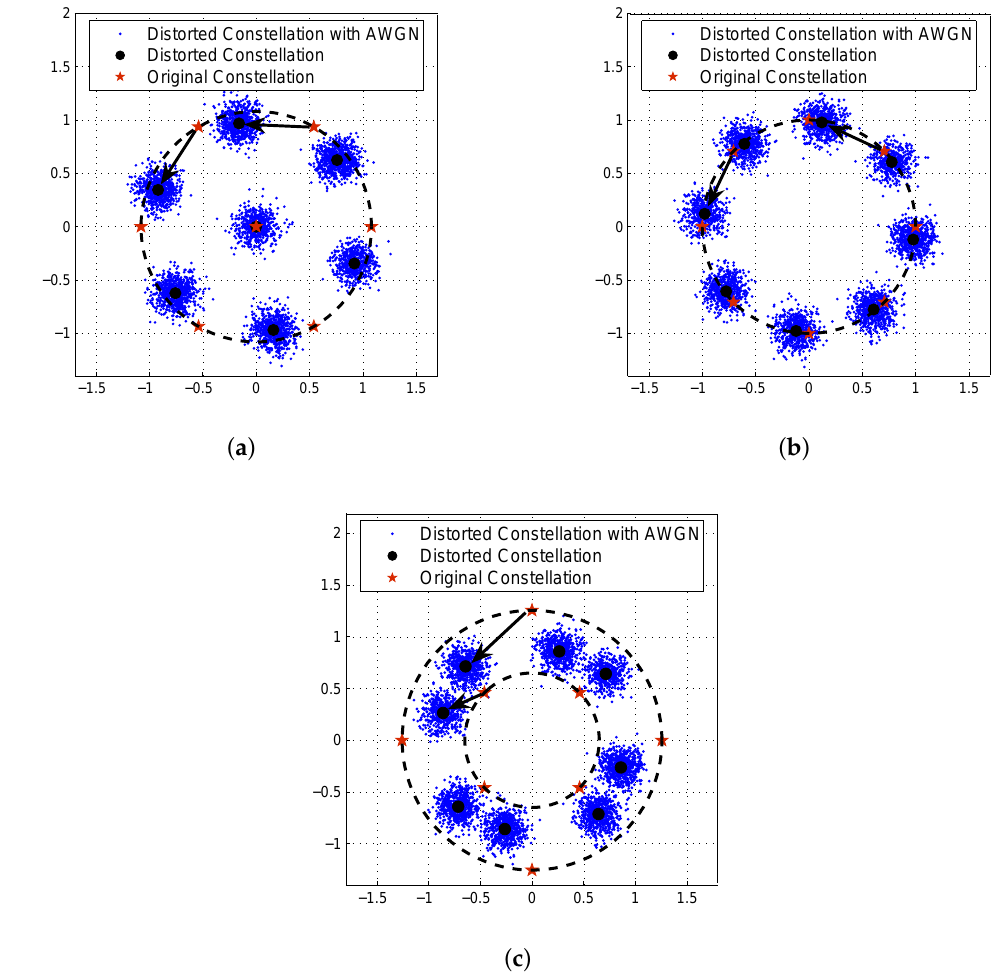
Figure 5. Original and distorted constellation diagrams. ( a ) 7-QAM; ( b ) 8-PSK; ( c )